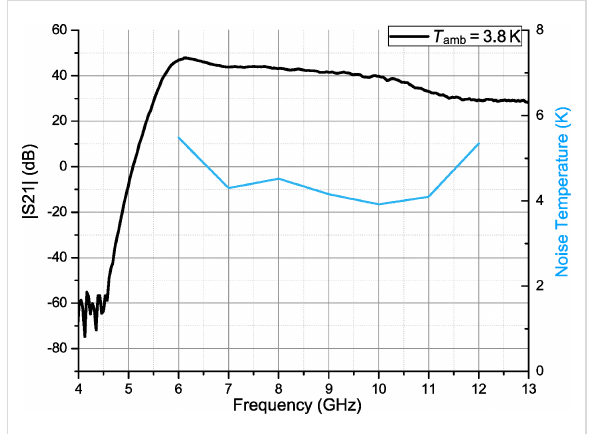
Figure 4: Gain and noise temperature of the cryogenic LNA at the ex- perimental temperature of 3.8